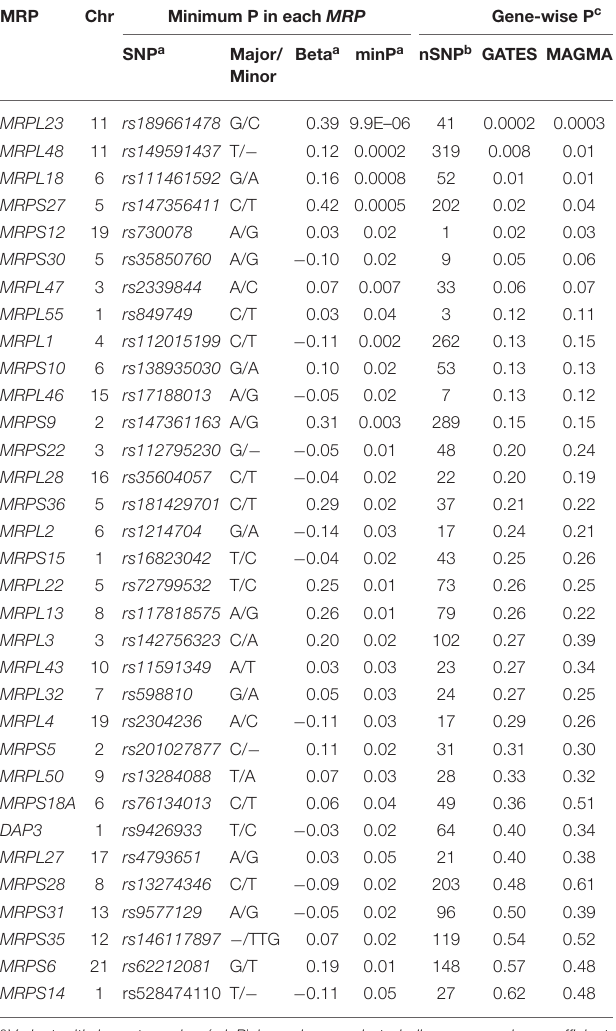
TABLE 3 | MRP genes ranked by minimum p -values and gene level association with cognitive